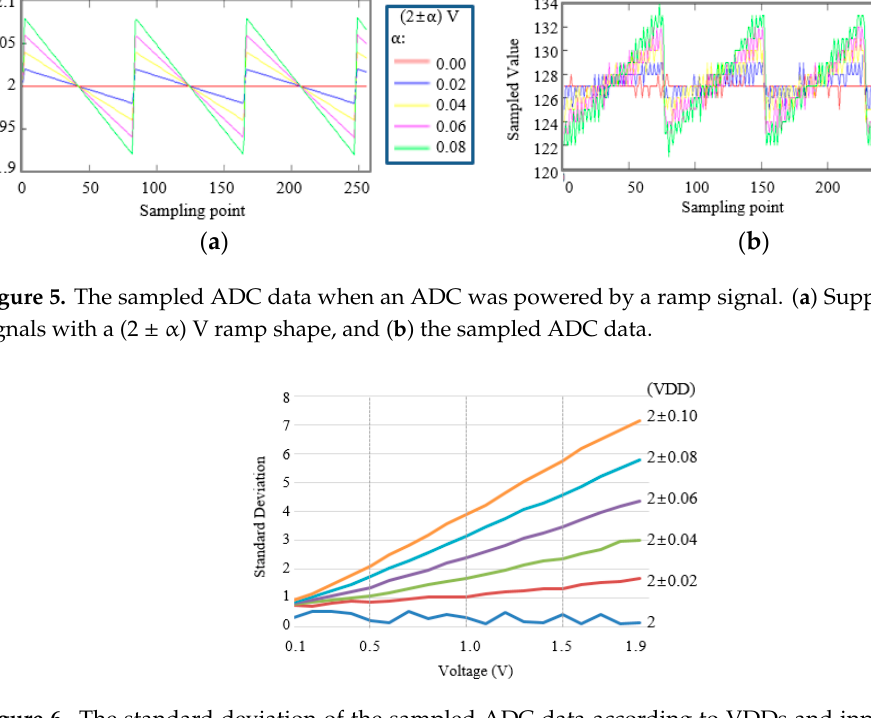
Figure 5. The sampled ADC data when an ADC was powered by a ramp signal. ( a ) Supply voltage signals with a (2 ± α ) V ramp shape, and ( b ) the sampled ADC data.